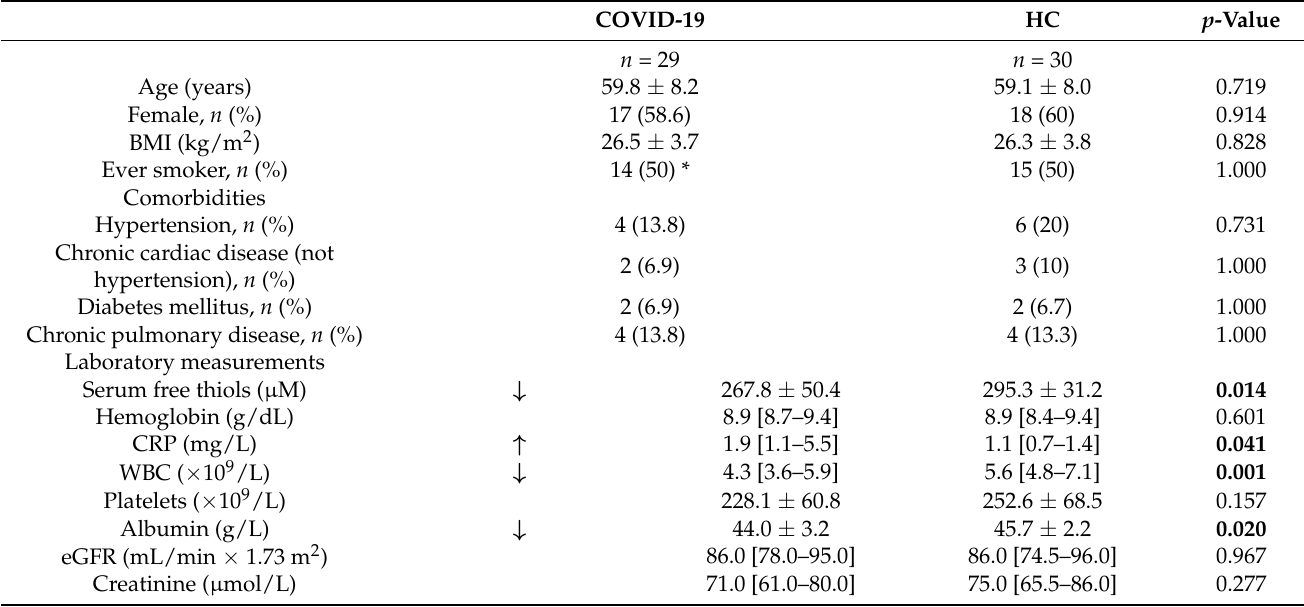
Table 1. Baseline demographic and clinical characteristics of subjects with mild COVID-19 and matched healthy controls.